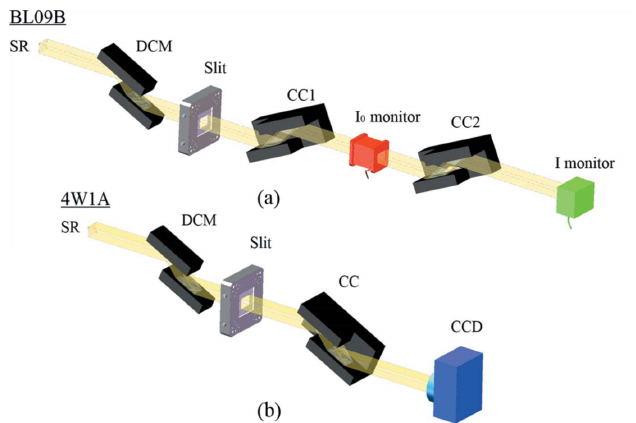
Figure 3 Schematic view of the experimental setup for ( a ) rocking-curve and reflectivity measurements at BL09B (SSRF) and 1B3B (BSRF) (opening size of slit: 5 mm horizontal, 1 mm vertical) and ( b ) X-ray topography measurements at 4W1A (BSRF) (opening size of slit: 5 mm horizontal, 5 mm